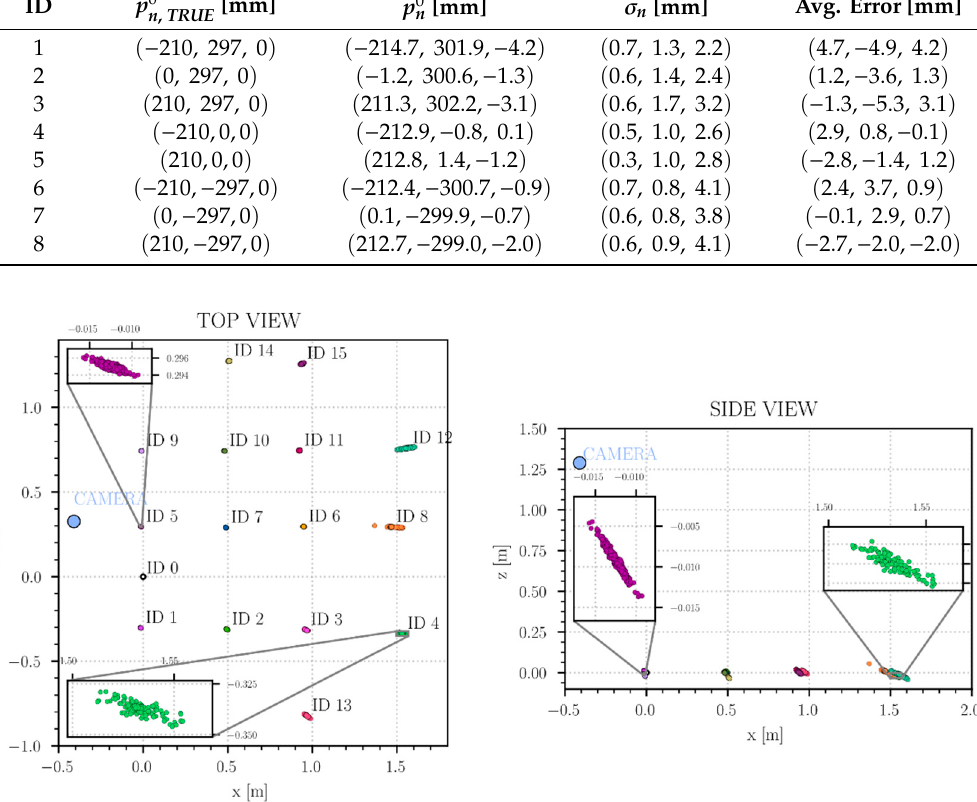
Figure 8. Results of the localization algorithm. Marker side length of 96mm. For the marker closest to the camera, the actual point distributions are significantly smaller than the points used in the pictures.